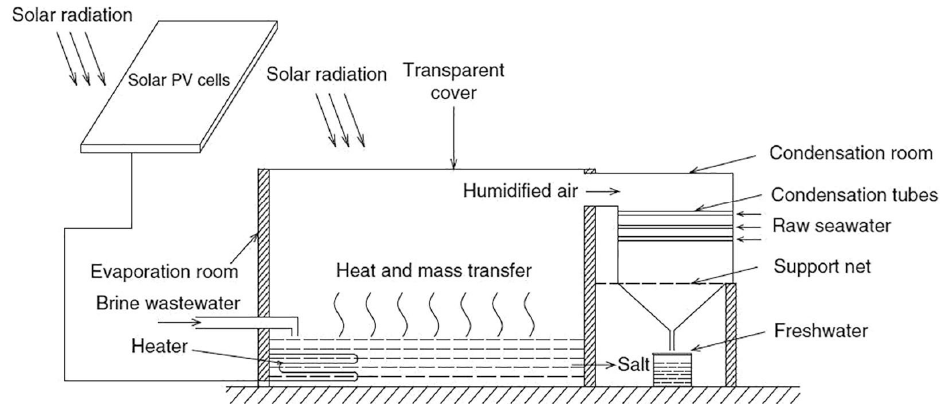
Figure 14. A photovoltaic-driven HD technique had been investigated in [131]. Table 8. A brief survey of the experimental literature on the photovoltaic-based HD process.